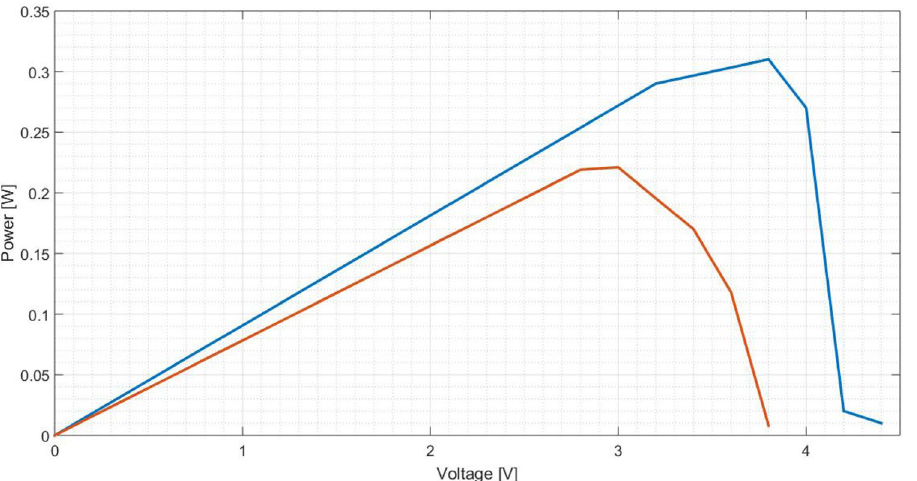
Figure 30. Comparison between P(V) curves of painted aluminium plate (Blue: Day 0; Red: Day